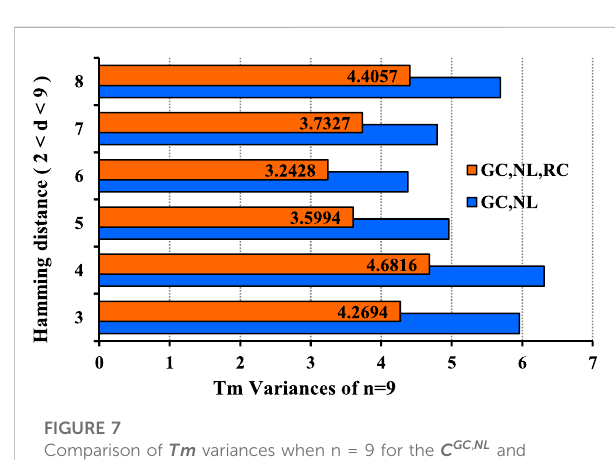
FIGURE 7 Comparison of Tm variances when n = 9 for the C GC , NL and C GC , NL , RC ( n , W , d )